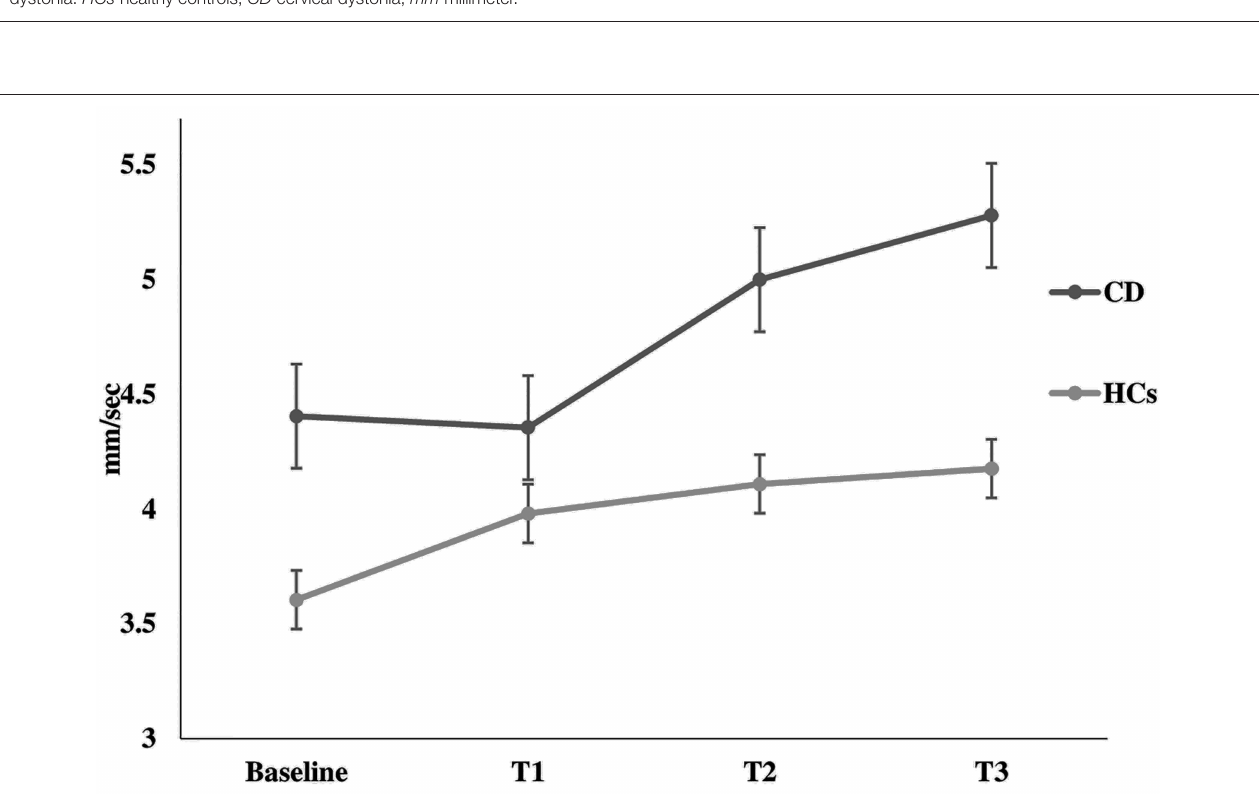
FIGURE 2 | Velocity of oscillation. Velocity of oscillation at rest (baseline) and during the execution of all Stroop test trials (T1, T2, T3) in healthy controls and in patients with cervical dystonia. HCs healthy controls; CD cervical dystonia; mm/sec millimeter/second.